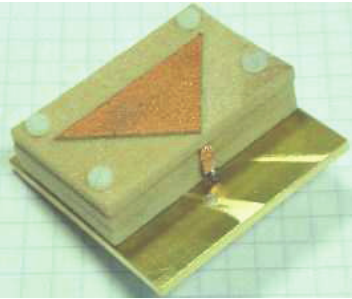
Figure 13: Triangular patch F-probe antenna using metallized foam technology.